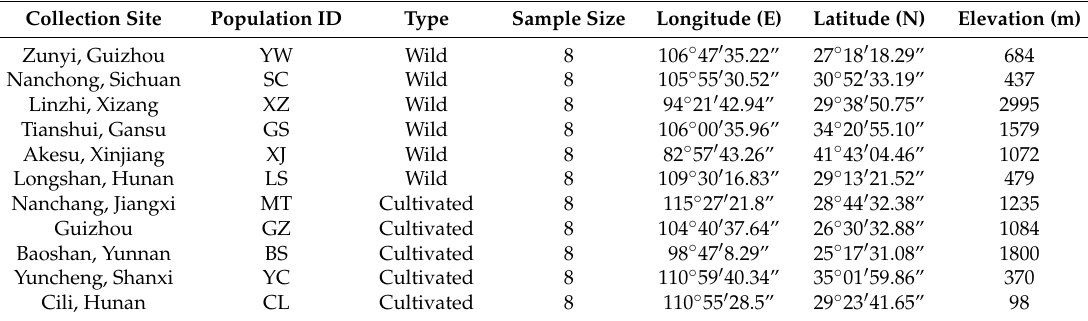
Table 1. Sources of samples of Juglans regia used for genotyping based on